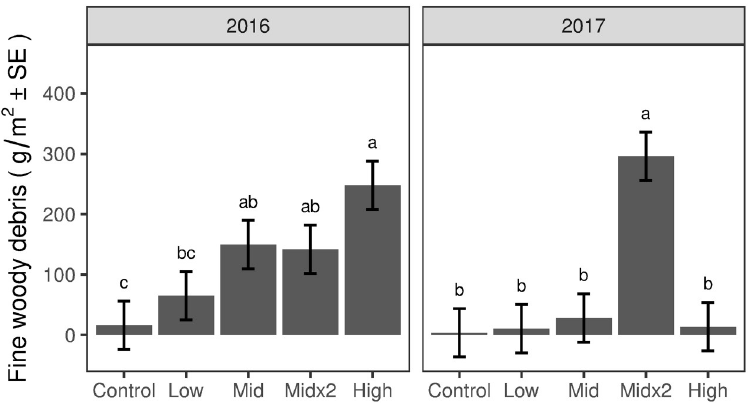
Fig 5. Post-icing FWD mass for winters 2016 and 2017. Different letters denote significant differences among treatments ( P < 0.05) within a sampling period. Vertical lines are 95% confidence intervals.